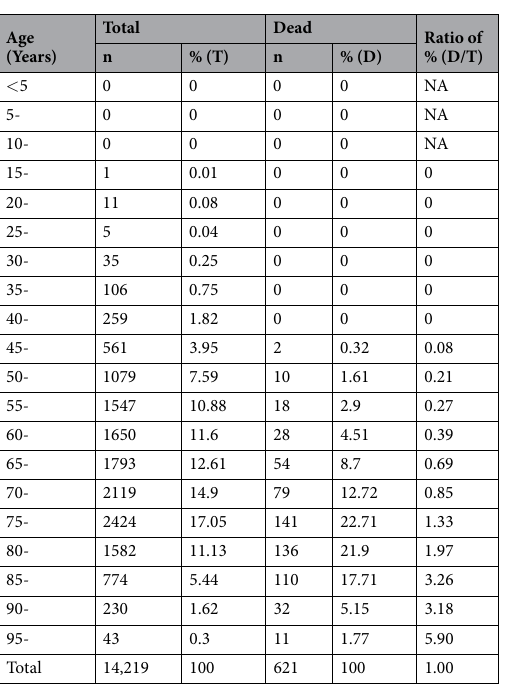
Table 1. Age distribution in hospitalized women with hypertension and dead ones. The data supports hypertension is an aged disease and the mortality increases with